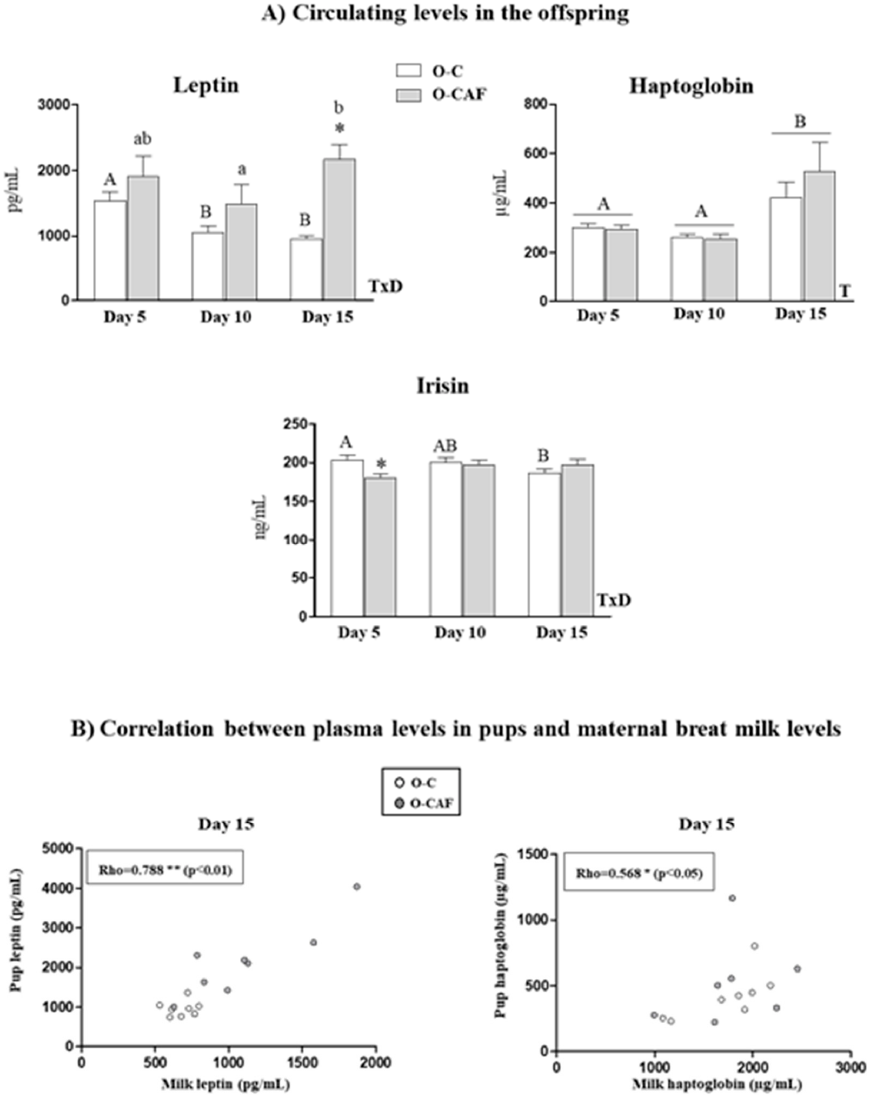
Figure 5. ( A ) Plasma leptin, haptoglobin and irisin concentration on days 5, 10 and 15 of lactation of o ff spring of dams fed with control (O-C) or a cafeteria diet during lactation (O-CAF). ( B ) Spearman correlations between maternal leptin and haptoglobin concentration in milk and plasma levels in pups on day 15 of lactation of control and cafeteria diet-fed dams. Data are expressed as the mean ± SEM of 16 animals per group. Statistics: T, e ff ect of time; TxD, interactive e ff ect between time and maternal diet, ( p < 0.05, ANOVA repeated measures). a (cid:44) b; x (cid:44) y ( p < 0.05, Bonferroni post-hoc test). *, cafeteria versus control diet ( p < 0.05, Mann–Whitney U test). The correlation was done by non-parametric Rho Spearman correlation with a statistical significance (2-tailed) * p < 0.05, ** p <